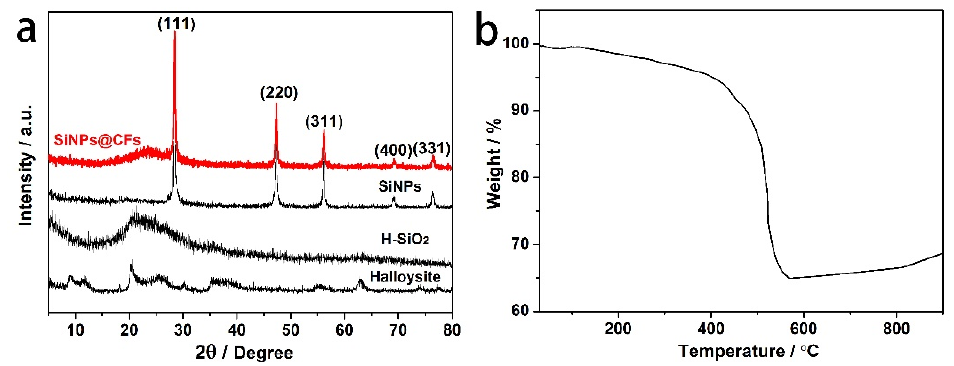
Figure 1. ( a ) XRD patterns of halloysite, H-SiO 2 , SiNPs, and SiNPs@CFs; ( b ) TGA curve of SiNPs@CFs.